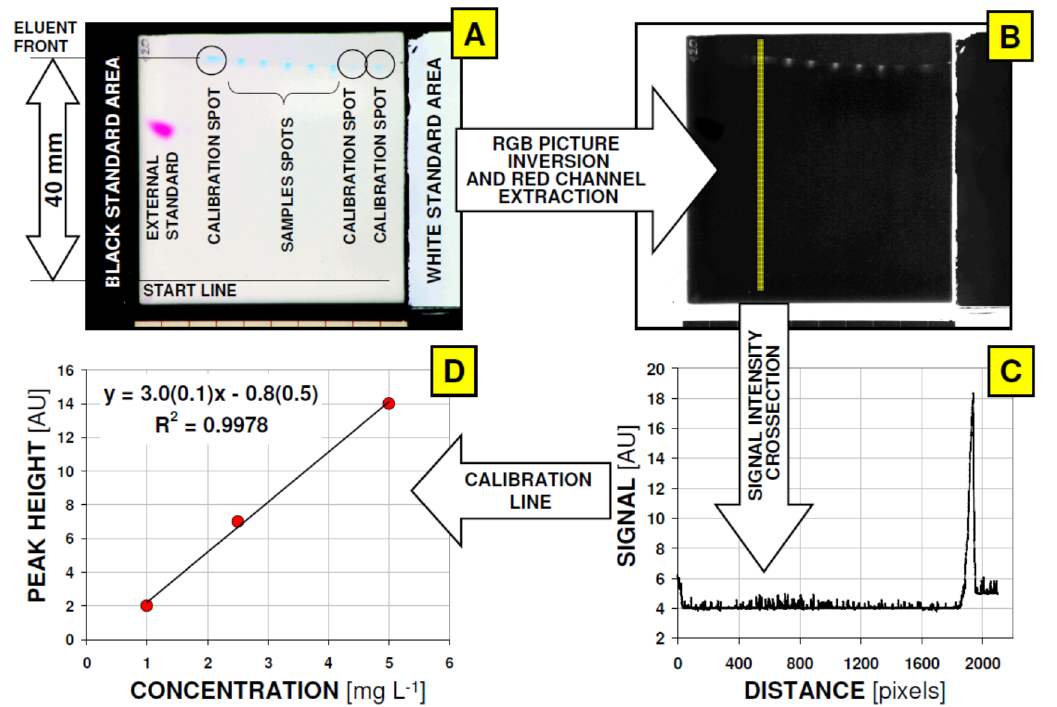
Figure 1. Applied sequence of quantification protocol for direct determination of Brilliant Blue dye in reaction mixtures using microfluidic analytical device based on micro-TLC plate. General view and spots arrangements of micro-TLC analytical device ( A ); to increase the contrast of spots for visual evaluation and printing a global balance filters were applied); converted picture prepared for spots quantification ( B ); to increase the contrast of spots for visual evaluation and printing a global balance filters were applied), Lane cross-section for given calibration spot ( C ); signal intensity data were derived from raw red channel without contrast enhancement); Calibration plot for individual m-TLC plate ( D ). External standard spot (Methyl Red; chromatographed mass 100 ng/spot) was used for accuracy of retention process and quantitative data validation.